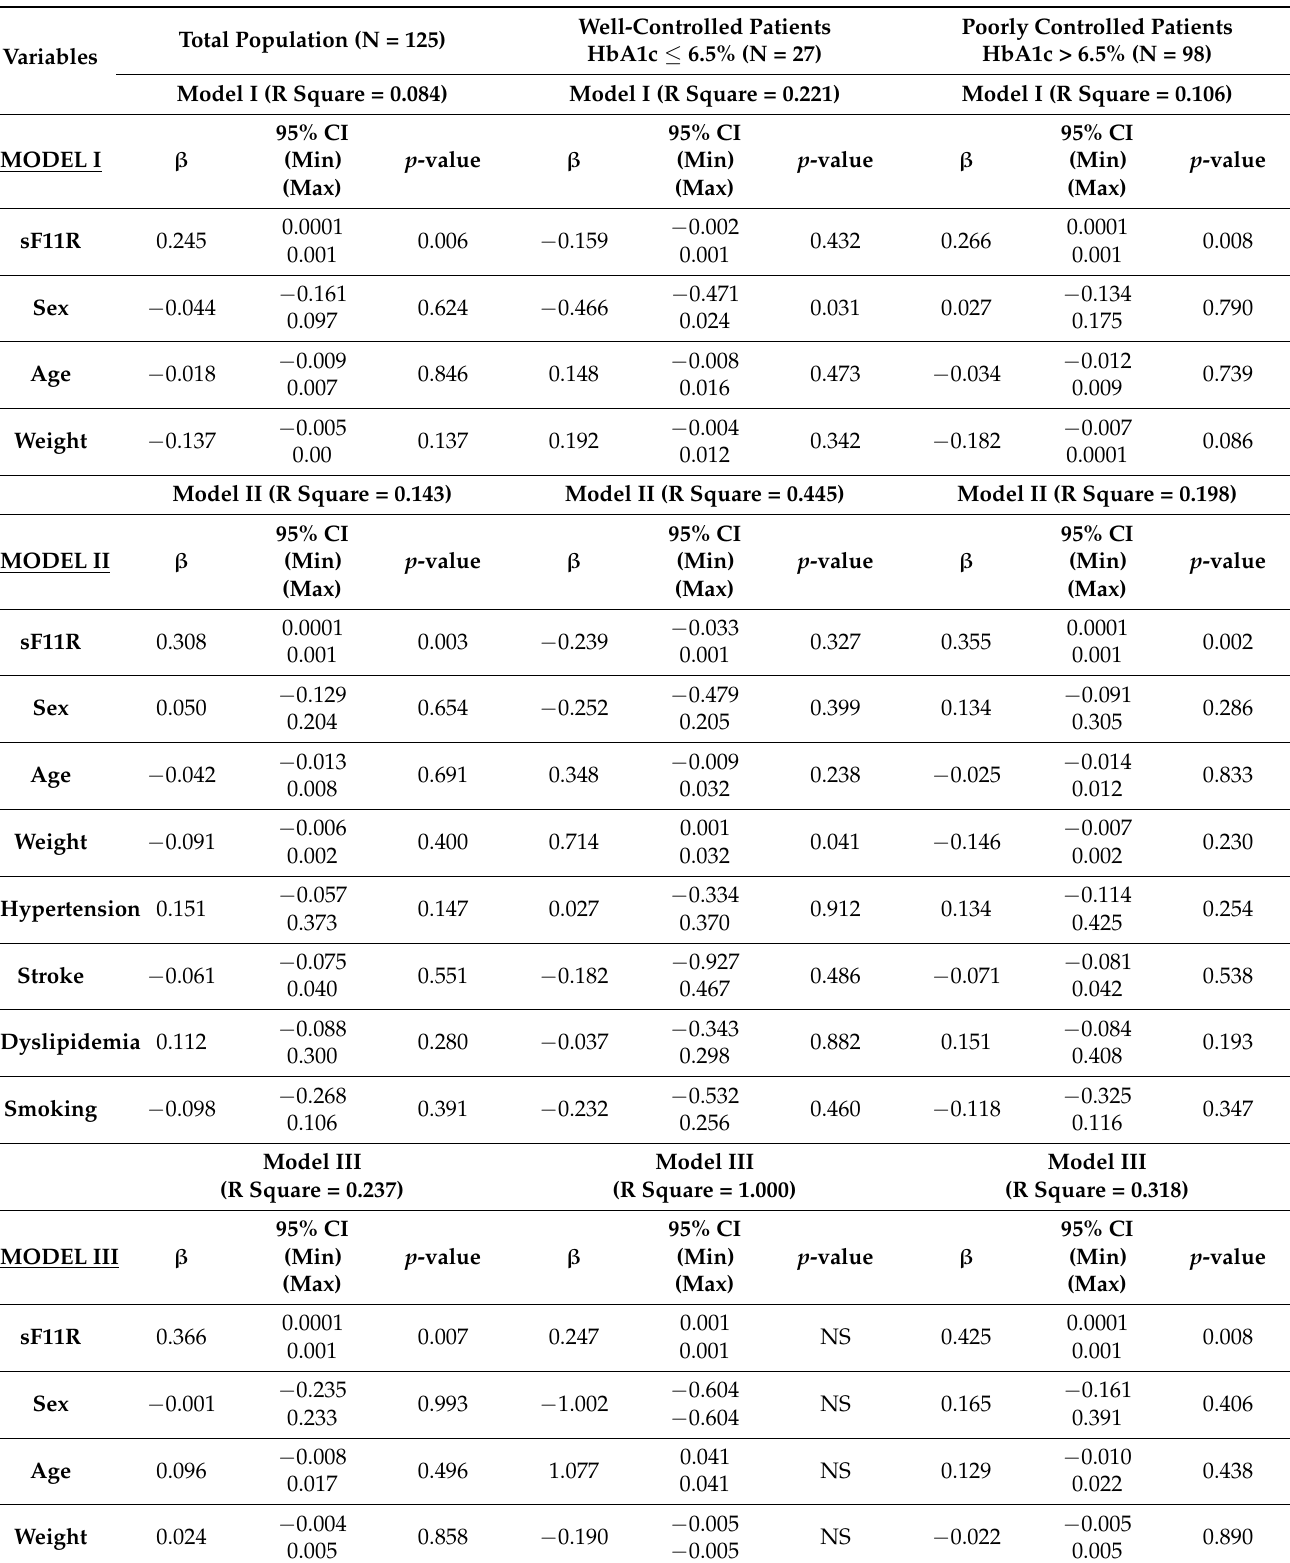
Table 4. Multiple regression analysis of the association between plasma sF11R and ANXA5